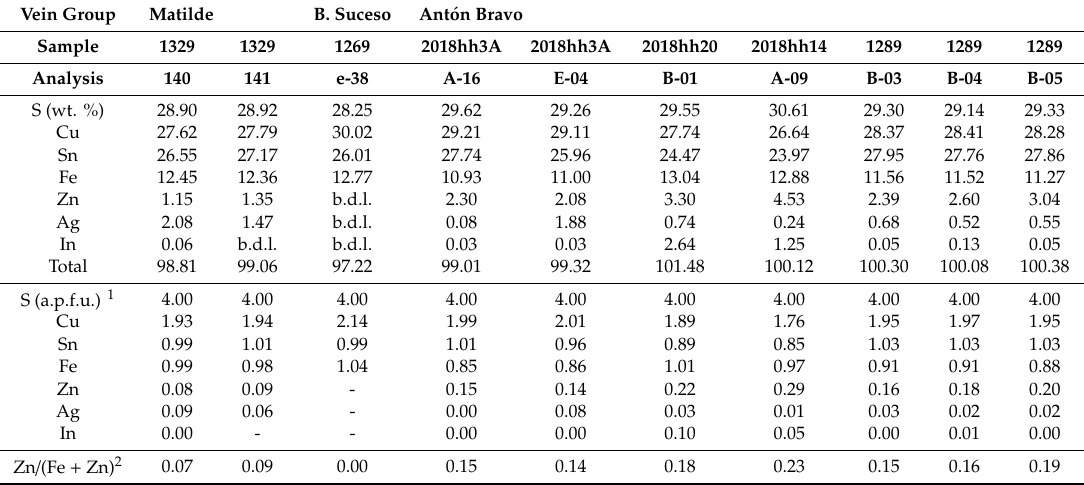
Table 4. Representative analyses of stannite group minerals from the Huari Huari district, including chemical composition and structural formulas normalized to S = 4 (electron-microprobe data). Lower detection limits are given in Table